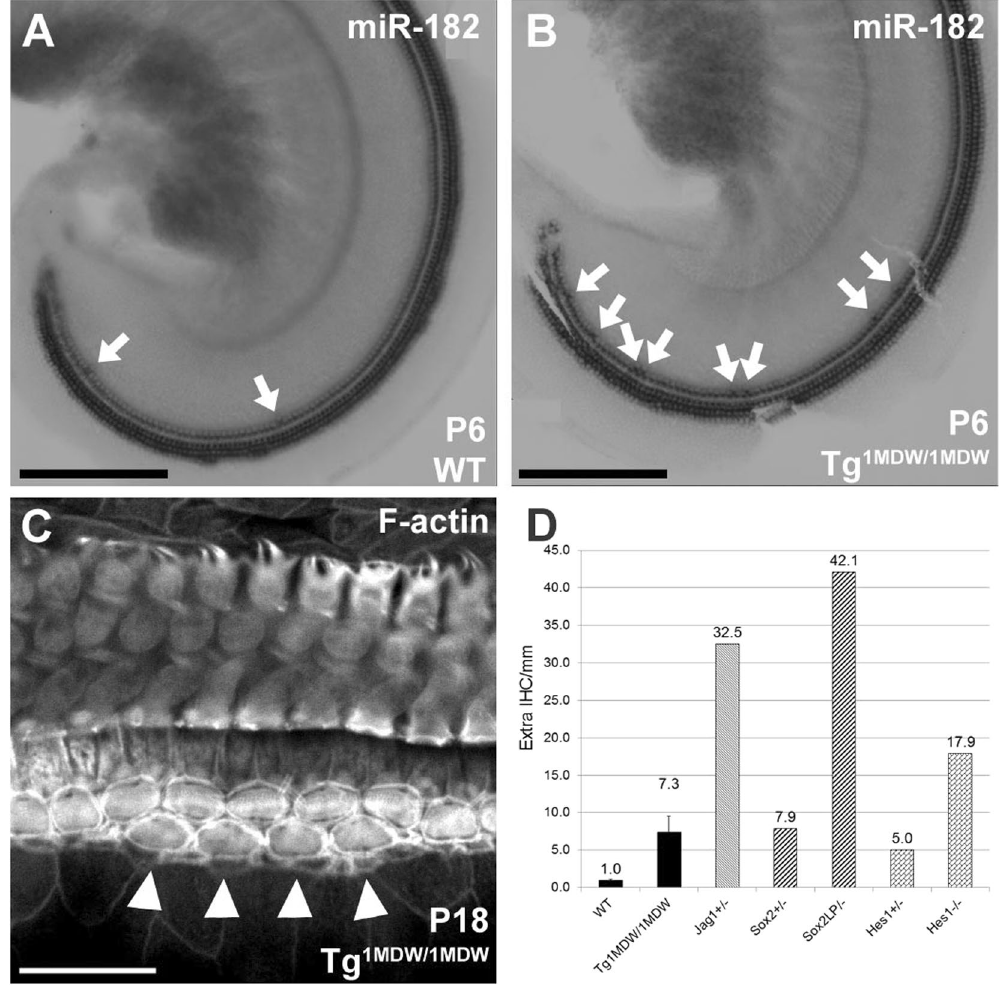
Figure 2. Excess IHCs are a consistent phenotype of prosensory/SC gene mutations. ( A , B ) Whole mount miR- 182 staining of HCs in the cochlear apex of P6 WT ( A ) and Tg 1MDW/1MDW ( B ) mice. Arrows point to additional miR-182 positive, medially placed IHCs. ( C ) Phalloidin-stained Tg 1MDW/1MDW OC at P18 with 4 contiguous, medially placed extra IHCs (arrow heads). ( D ) Mean extra IHCs per 1 mm distance was plotted and compared with other published mouse mutants. Mutations in genes that are predicted targets of the miR-183 cluster phenocopy Tg 1MDW/1MDW -mediated increases in IHCs. Phenotypic correlation of extra IHCs in SC-specific single-gene mutants are consistent with negative regulation of these predicted miR-183 cluster target genes. Scale bar: 200 μ M ( A , B ); 20 μ M ( C